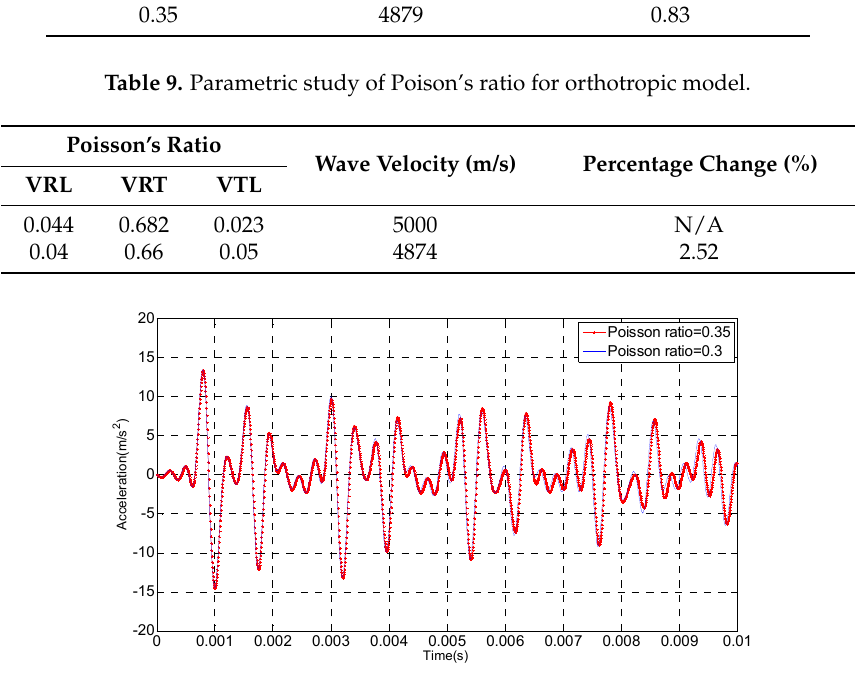
Figure 18. Poisson’s ratio influences on wave behaviour in isotropic material model.